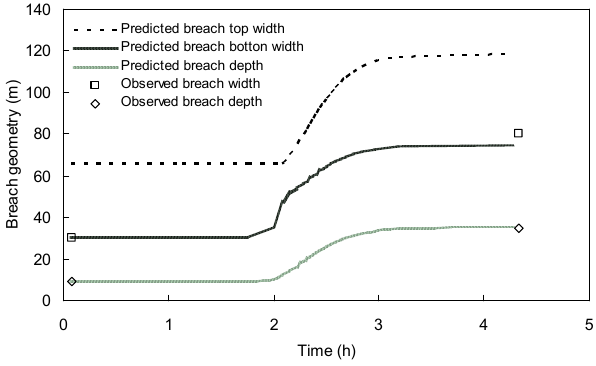
Fig. 13. Predicted and observed evolution of breach size for the Xiaogangjian landslide dam.